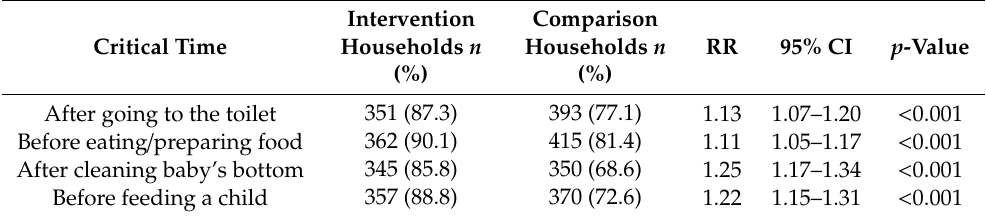
Table 7. Frequency of those self-reporting that they ‘always’ wash hands at critical times in intervention and comparison